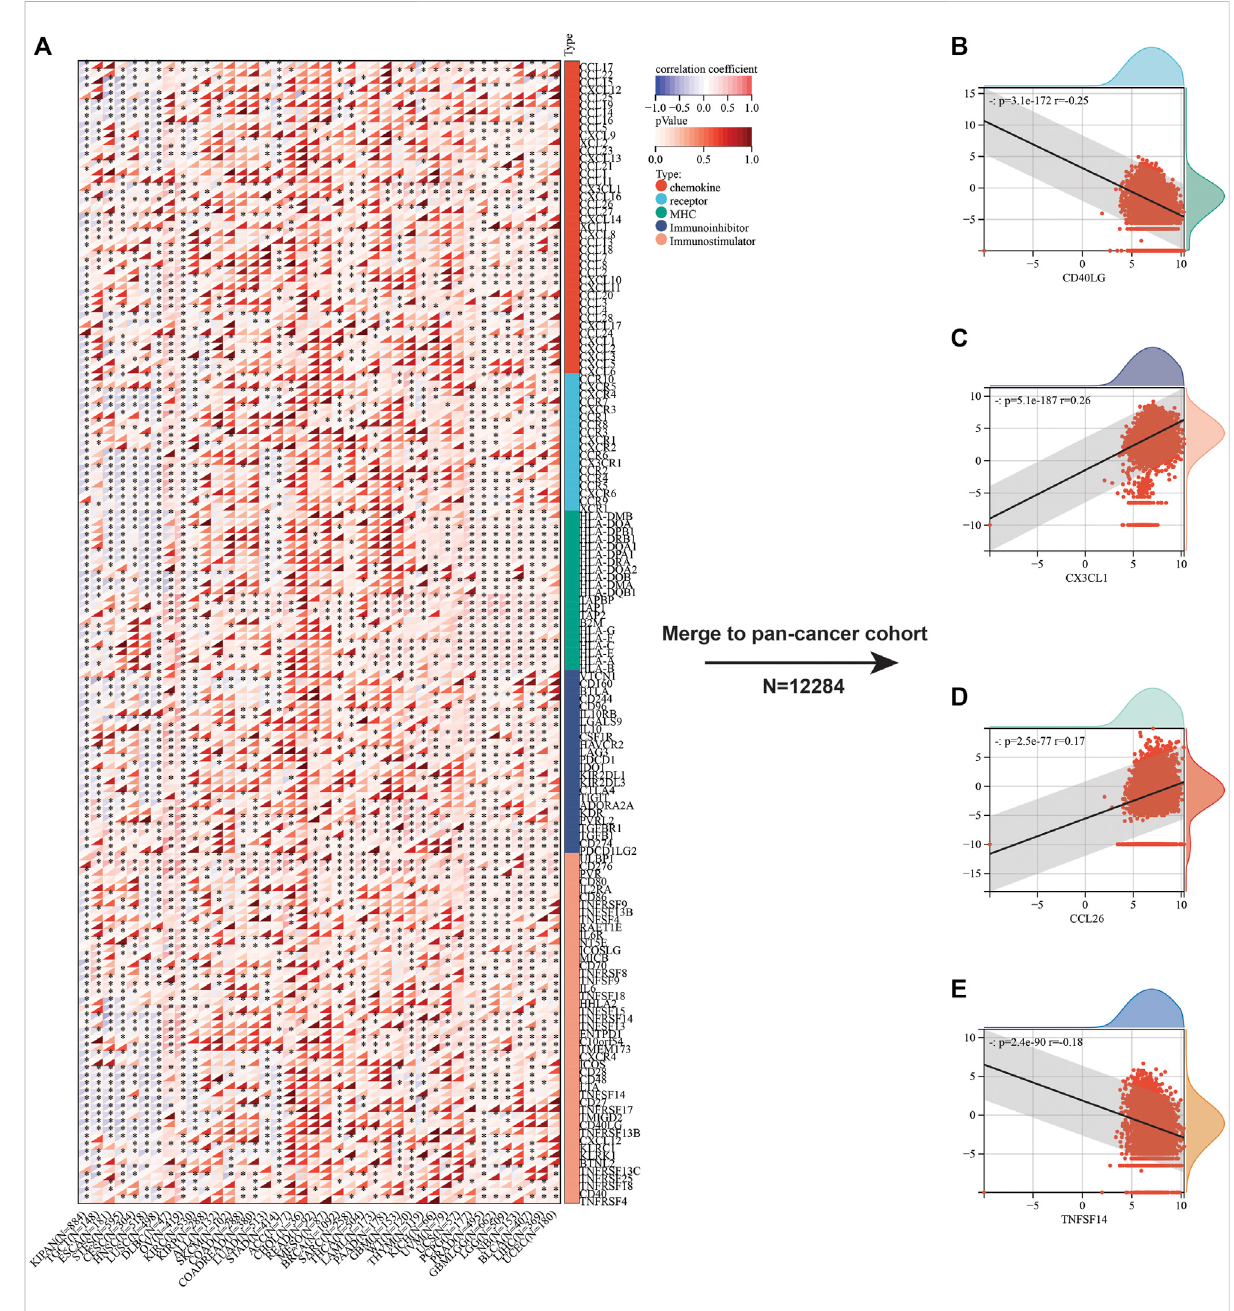
FIGURE 5 Correlation between immunoregulators and SLC3A2 expression in cancers. (A) Heatmap showed the correlation between each immunoregulator and SLC3A2 in every cancer. (B – E) Association between SLC3A2 and CD40LG, CX3CL1, CCL26, and TNFSF14 in a large pan- cancer cohort that merged by all cancer